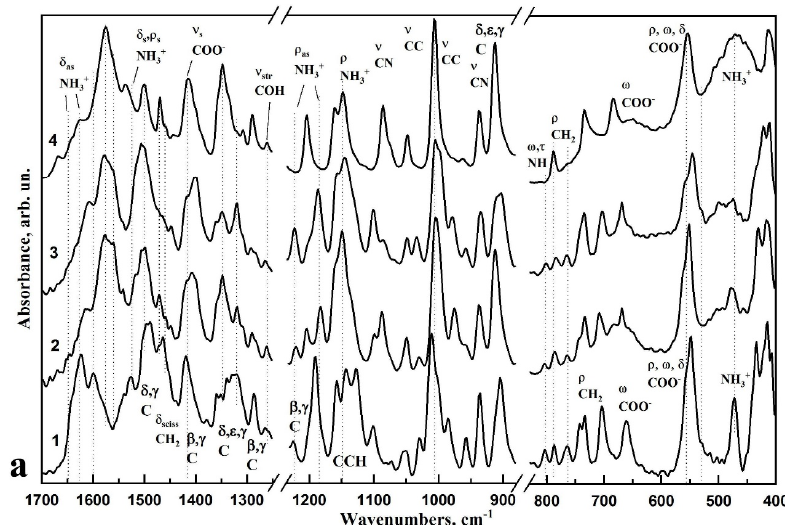
Figure 4. FTIR absorption spectra of the amino acid samples: ( a ) L-LysHCl in the original crystalline state (curve 1) and crystallised from solutions at pH ≤ 5 (curve 2), pH ≥ 7.5 (curve 3) and pH ≥ 11.2 (curve 4); ( b ) L-ArgHCl in the original crystalline state (curve 1) and crystallised from solutions at pH ≤ 5 (curve 2), pH ≥ 7.5 (curve 3) and pH ≥ 11.2 (curve 4).